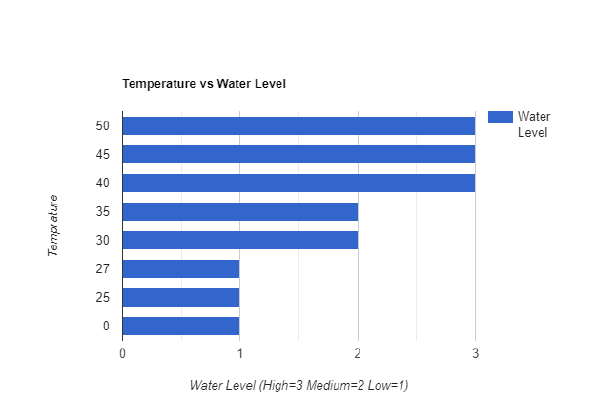
Fig4.(e)Graph of temprature vs water level